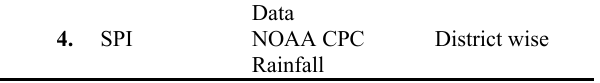
Table 1: Details of satellite data products used in the